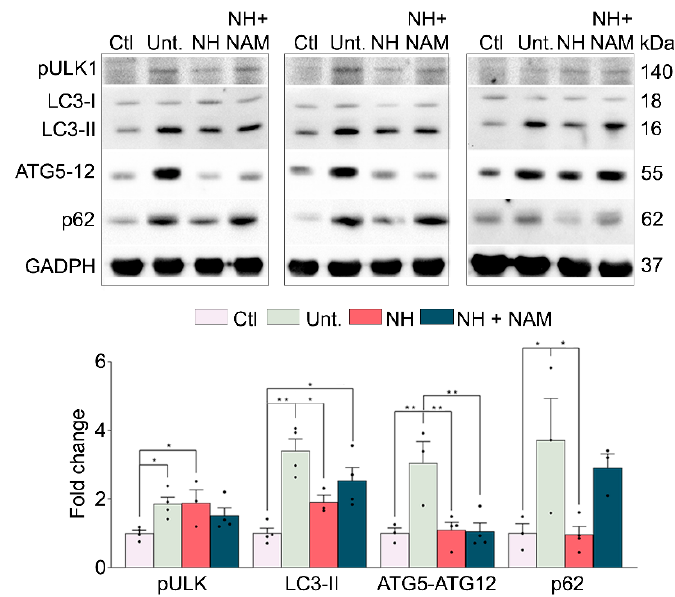
Figure 5. Autophagy flux is modulated by NeuroHeal in the denervated muscle model. Western blots and the associated bar graphs showing the analyses of phosphorylated ULK1, LC3-II, the ATG5-ATG12 complex, p62, and protein levels in different experimental groups at 7 dpi (control (CTL), injured untreated (Unt.), injured treated with NeuroHeal (NH), and injured treated with NH plus nicotinamide (NAM)) ( n = 3–4; one-way ANOVA, * p < 0.05).